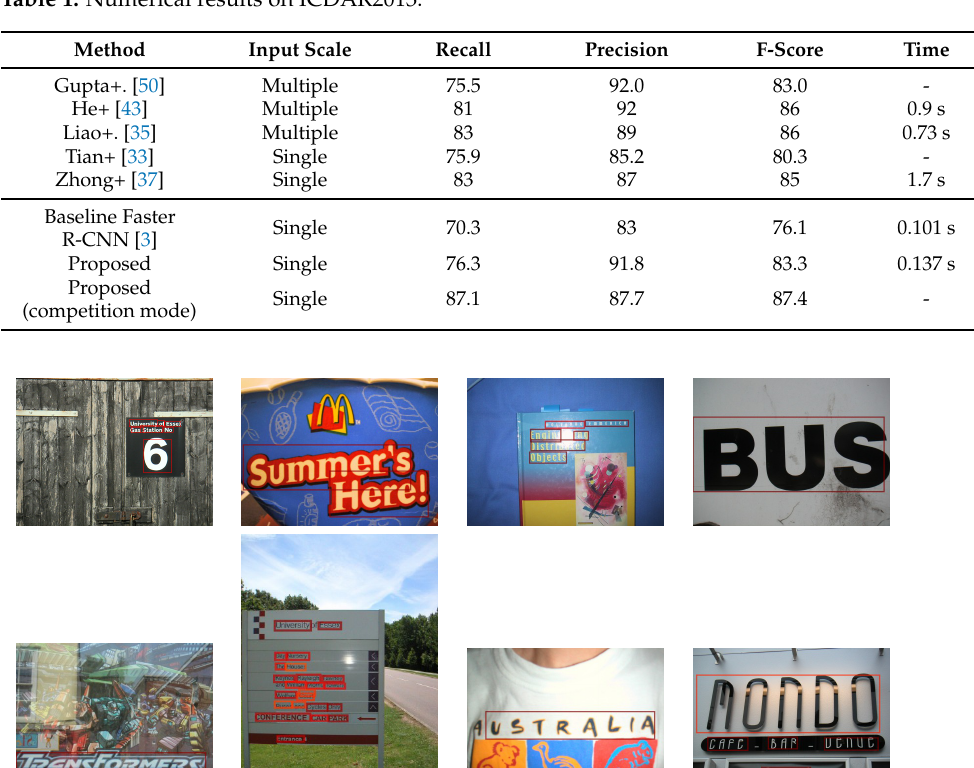
Table 1. Numerical results on ICDAR2013.